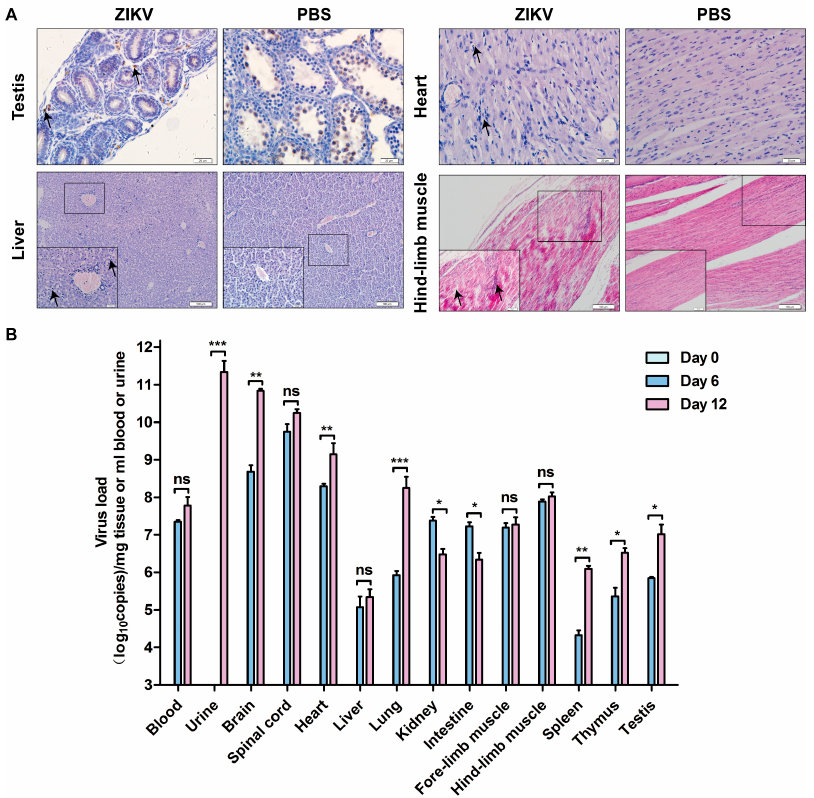
Figure 4. ZIKV infects multiple organs of neonatal C57BL/6 mice. ( A ) Immunohistochemistry (IHC) analysis of tissues after being infected with PRVABC59. The 1-day-old C57BL/6 mice were infected i.p. with 10 6 TCID 50 PRVABC59 per mouse or PBS. Mice were sacrificed at 11 dpi to isolate tissues for sectioning and being stained by IHC method. Representative pictures from PRVABC59-infected tissue slides were selected to show: testis, heart, liver, and hind-limb muscle; ( B ) Real time RT-PCR. The 1-day-old mice were infected i.p. with 10 6 TCID 50 PRVABC59 per mouse for different days as indicated. The mice were then dissected following euthanasia at 0, 6, and 12 dpi to isolate the organs and tissues as indicated: blood, brain, spleen, heart, intestine, urine, heart, lung, fore-limb muscle, thymus, liver, kidney, hind-limb muscle, and testis. Total RNA samples were prepared using a GenMagSpin Viral DNA/RNA Kit (GenMag Bio, Beijing, China), and real-time RT-PCR was performed to determine the ZIKV RNA level in the isolated or collected organs and tissues. For each length of time kept, we used three mice. The average number of the RNA copies from the real time RT-PCR was obtained statistically with GraphPad Prism Software version 5.01. (the statistical significance was not determined. The graph only showed the average ± S.D.). Unpaired t test was used for statistical analysis. * p < 0.05, ** p < 0.01, *** p < 0.001, ns: not significant. Scale bars: A upper 20 µ m, A lower 100 µ m.